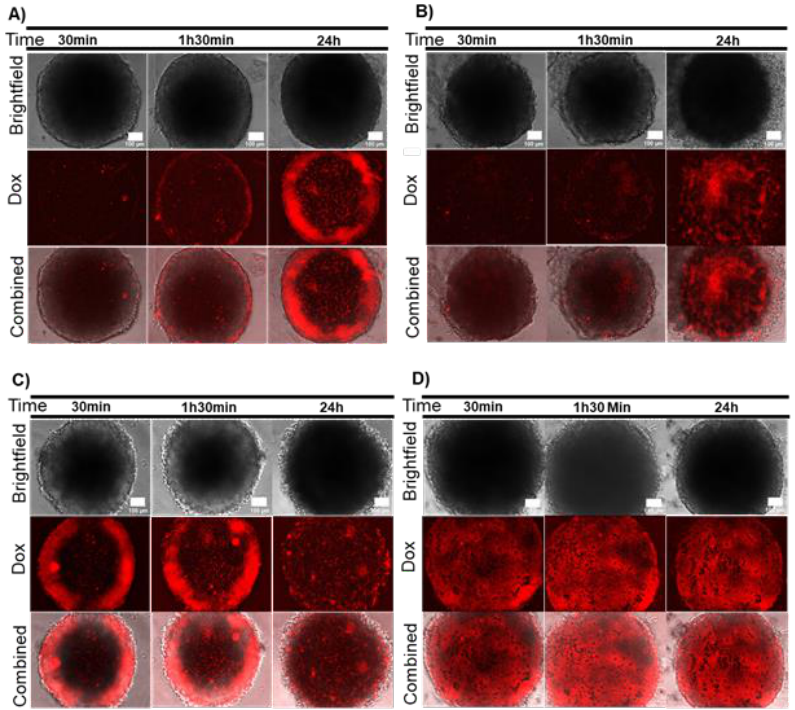
Figure 5. Effect of AuNPs and irradiation on Doxorubicin (Dox) diffusion in HCT116 spheroids. ( A ) HCT116 spheroids irradiated with a 532-nm laser for 1 min and then incubated with 8 μM Dox; ( B ) HCT116 spheroids incubated with 8 nM AuNP@PEG, irradiated with a 532-nm laser for 1 min and then incubated with 8 μM Dox; ( C ) HCT116 spheroids incubated for 6 h with 8 μM Dox and then irradiated with a 532-nm laser for 1 min; ( D ) HCT116 spheroids incubated with 8 nM AuNPs, incubated for 6 h with 8 μM Dox and then irradiated with a 532-nm laser for 1 min. Microscopy images were acquired in Brightfield or with a red fluorescence filter after 30 min, 1 h 30 min or 24 h incubation. The combined images result from the overlap between Brightfield and red filter images. Scale bar corresponds to 100 μm.